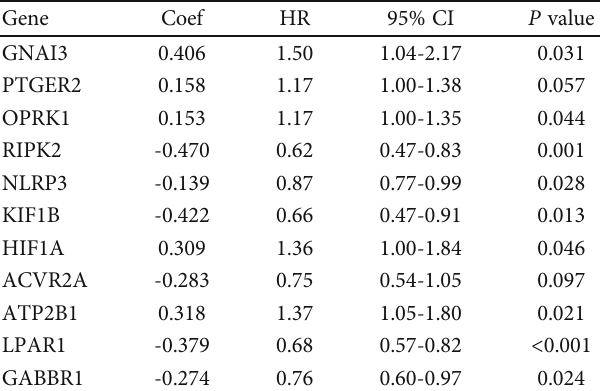
Table 2: The information of 11 EFS-related IRRGs by multivariate Cox regression